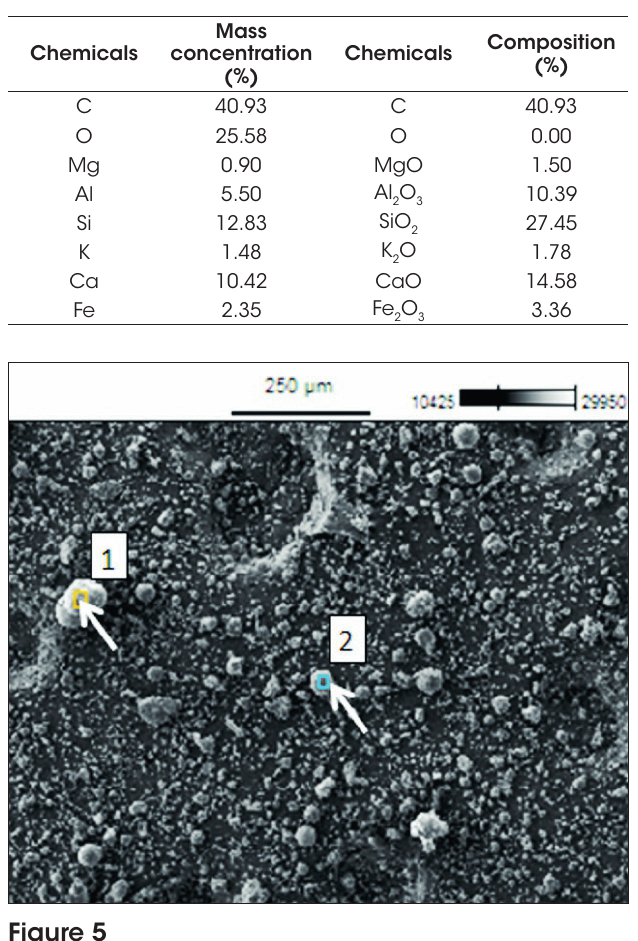
MEB image of the rubber powder and selected places for applying EDS